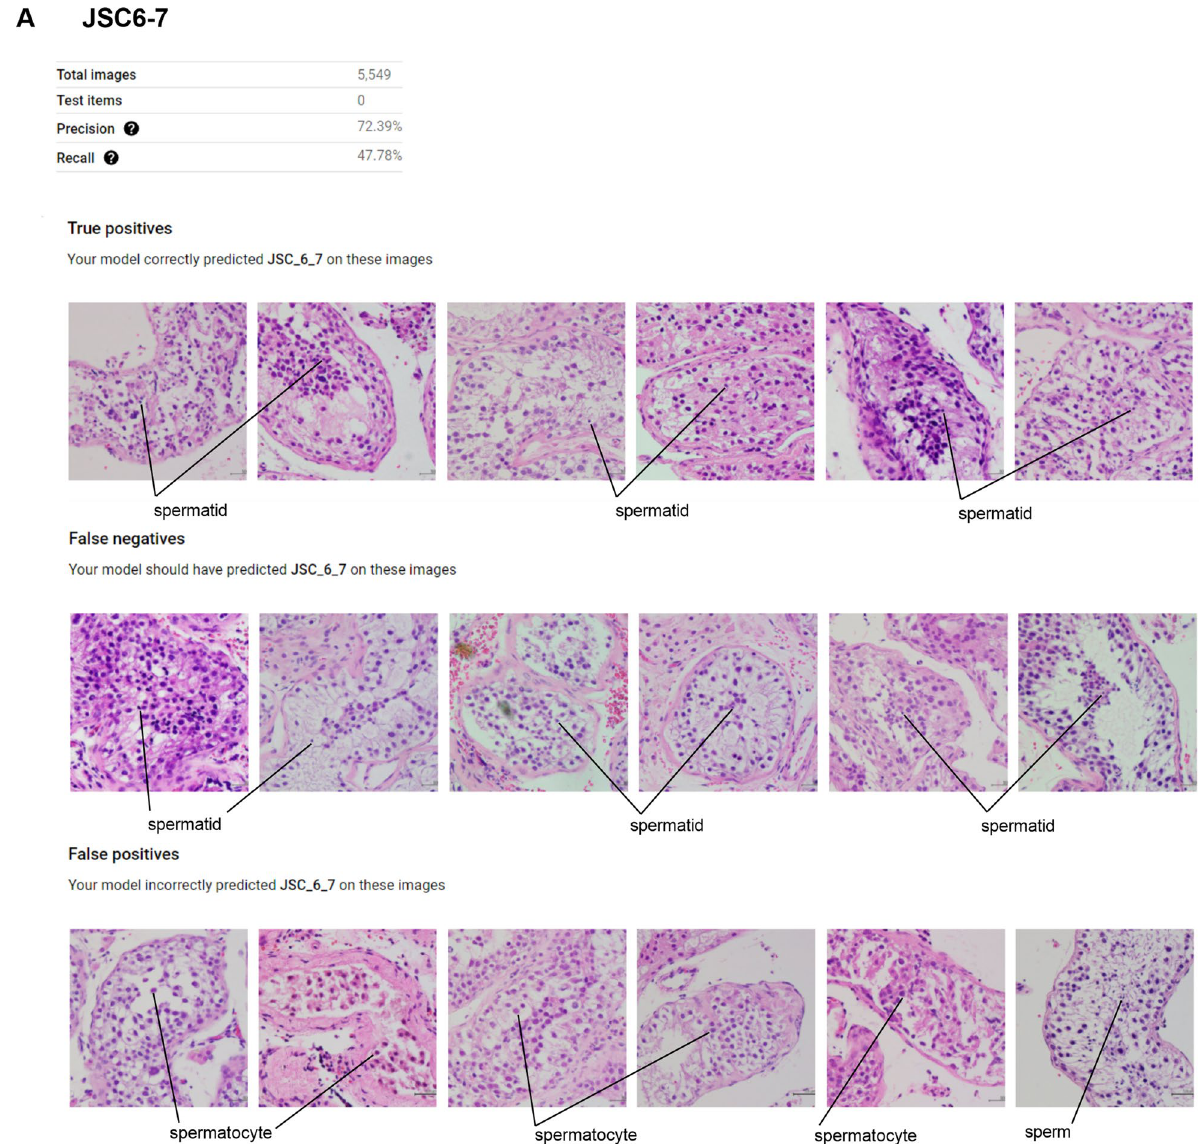
Figure 4. Features of true positives, false negatives, and false positives for